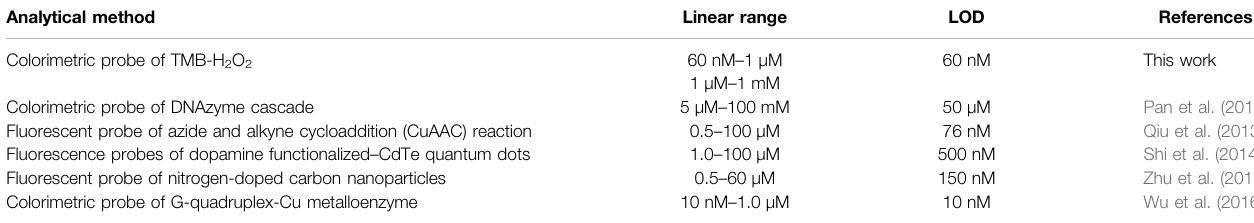
TABLE 1 | Comparison of different methods for L-histidine (L-His) detection. Analytical method